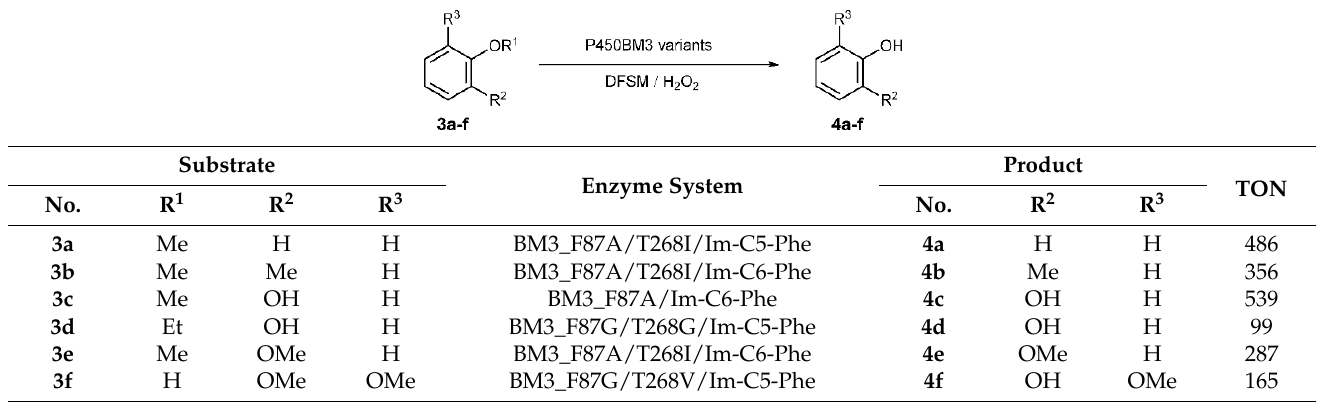
Table 2. Regioselective aromatic O-dealkylation by the DFSM-facilitated P450 peroxygenases.